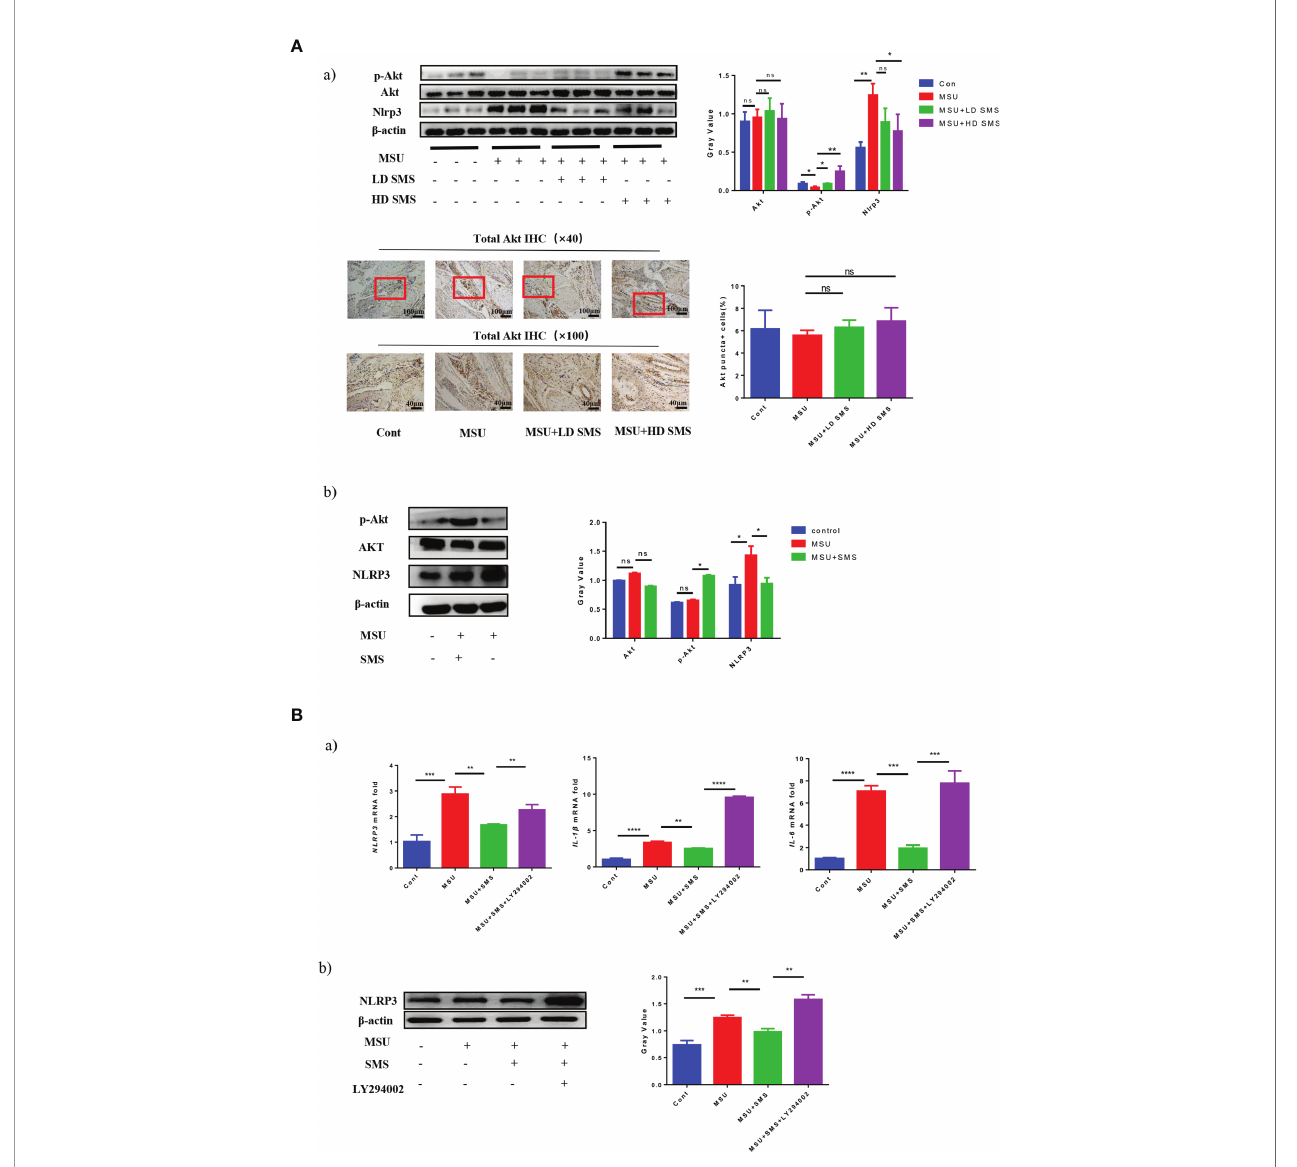
FIGURE 2 | SMS ameliorate gouty arthritis by PI3K/Akt pathway. The expression of Akt, p-Akt (Ser473) and Nlrp3 protein was detected by Western blot analysis in the MSU injured joints of the mice, and total Akt expression was detected by IHC staining (Aa) . In vitro , p-AKT (Ser473), AKT and NLRP3 protein was detected by Western blot analysis in the THP-1 cells treated by MSU with/without SMS (Ab) . Akt activation was inhibited by LY294002, the expression of NLRP3, IL-6 and IL-1 b were detected by RT-PCR (Ba) or Western blot analysis (Bb) . (mean ± SEM. ns p > 0.05, *p < 0.05, **p < 0.01, ***p < 0.001, ****p < 0.0001; n = 6/group; LD SMS: 1mg/kg.day low dose SMS; HD SMS:10mg/kg.day high dose